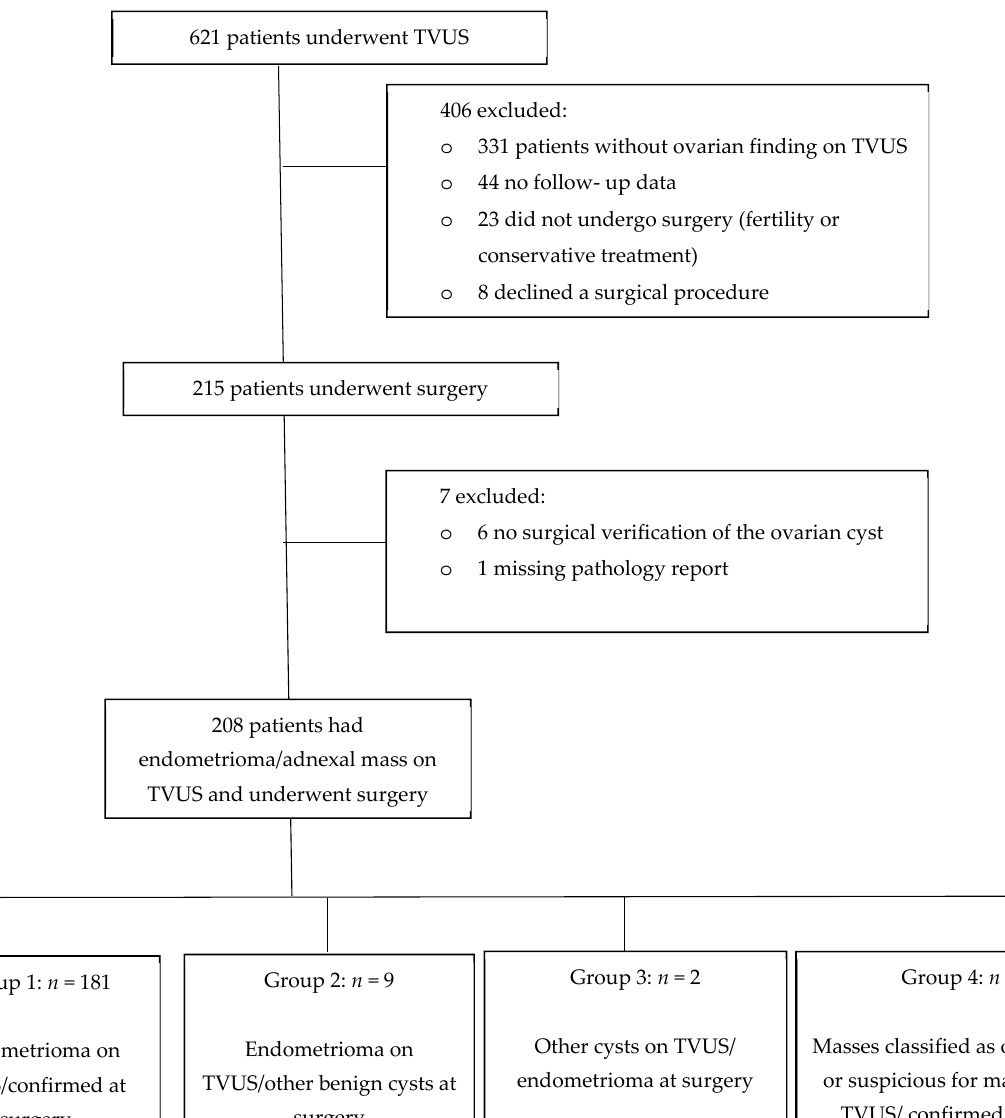
Figure 1. Study flowchart. TVUS (transvaginal ultrasound). In group 2 the pathological results were: 5 follicular luteinizing cysts, 2 hemorrhagic corpus luteal cysts, 1 serous cystadenofibroma. One of the patients had an inconclusive pathology result, the differential diagnosis was: epidermal inclusion cyst, benign cystic Brenner tumor and/or benign mucinous cyst with extensive squamous metaplasia. In group 3, two women presented with clear cysts on TVUS which were found to be endometrioma on pathology. Both of the patients had extensive endometriosis with adenomyosis and DIE. One of the patients had bilateral clear cysts on TVUS with a maximal diameter of 27 mm on the left ovary, while on surgery and pathology an endometrioma was confirmed. For the second patient, both TVUS and surgery misdiagnosed a clear cyst (23 mm clear cyst without flow was evaluated on TVUS), while pathology confirmed an